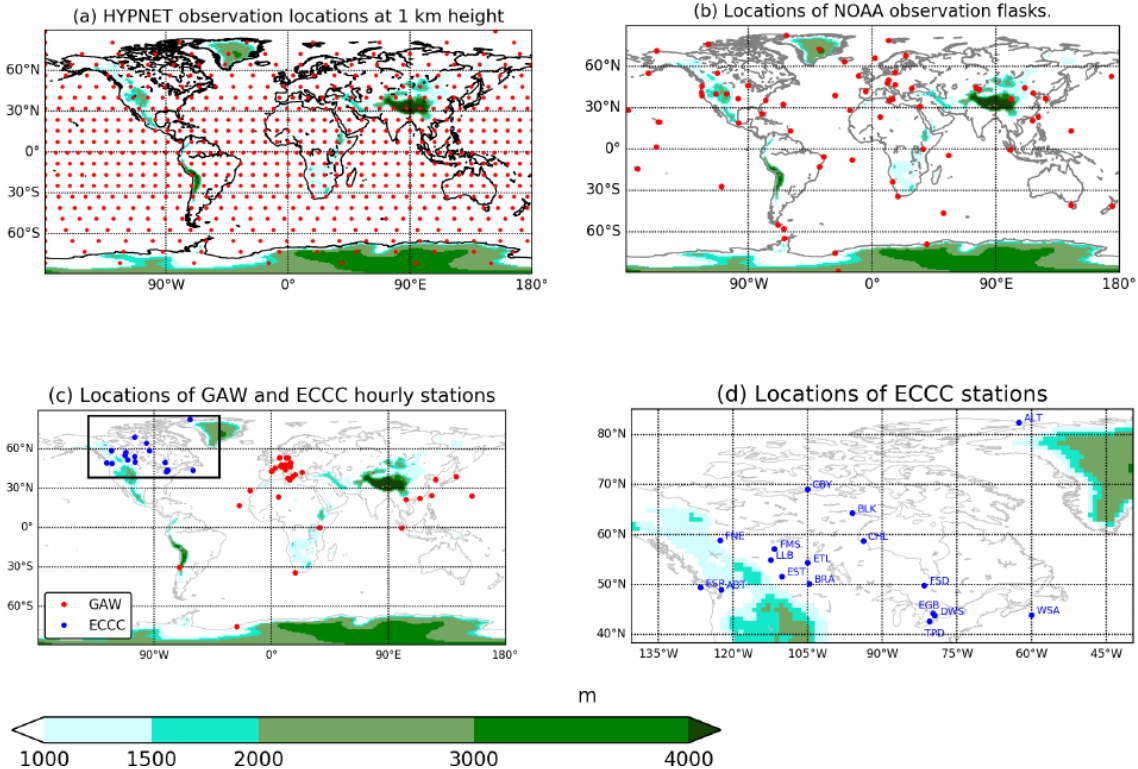
Figure 3. In each panel, topography is shown using color (see color scale). (a) HYPNET exists at 1, 5 and 9km. At each of these levels, the observations are located 1000km apart in the horizontal. There are 622 observation locations at each height and a total of 622 × 3 = 1866 observations every 6h. (b) The locations of flask observations from the NOAA network. (c) The GAW and ECCC station locations. (d) The ECCC station locations, which are also shown in the inset of panel (c) .